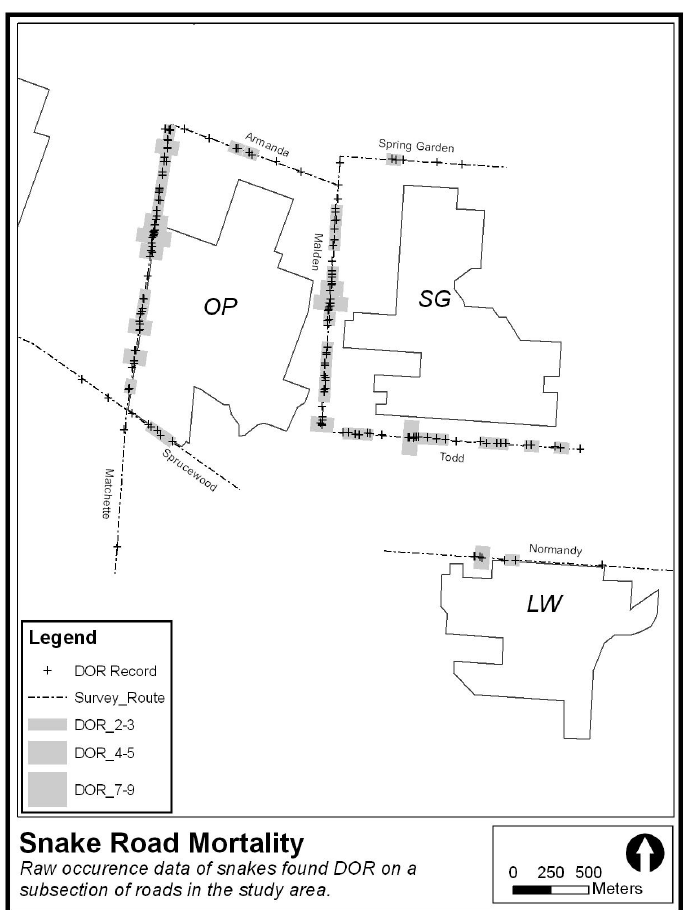
Figure 4. Snake ‘dead on road’ (DOR) records and frequency of DOR per 100 m road segment for roads surrounding the Ojibway Prairie Complex in southwestern Ontario, Canada [46]. Records of five species are compiled using systematic (2010) and incidental observations (2005–2010): Eastern Foxsnake, Dekay’s Brownsnake, Red-bellied Snake, Butler’s Gartersnake, and Eastern Gartersnake. Each cross represents one record from one individual snake.